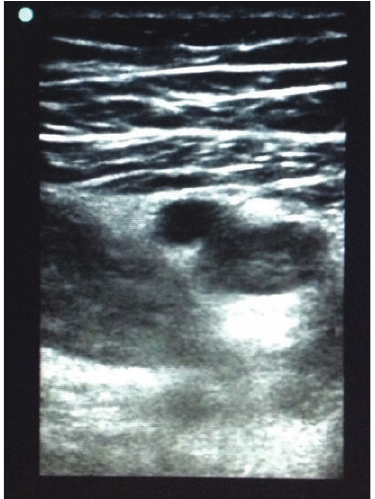
Figure 1: Compression of the common femoral vein at the level of the bifurcation of the common femoral artery.